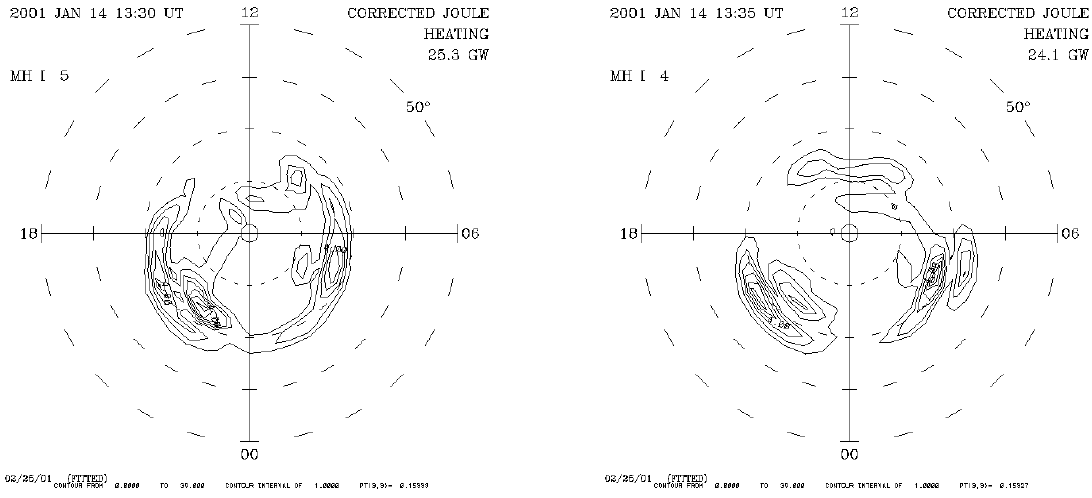
Fig. 7a. AMIE model results for two instances (13:30 and 13:35 UT) during the maximum phase of the flow-channel development on 14 January 2001. Global iso-contour patterns of the calculated Joule heating are shown in invariant latitude-MLT frames.